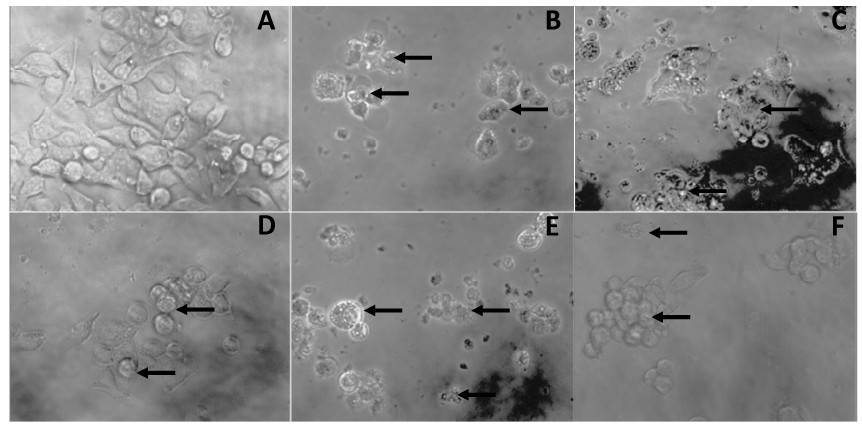
Figure 2. Pro-apoptotic events after 48 h in LS180 cells. Control cells ( A ); treated with gallic acid ( B ); quercetin ( C ); free phenolic extract ( D ); alkaline-treated fraction ( E ); or acid-treated fraction ( F ). Photomicrographs were taken at 100× magnification. Arrows indicate signs of cell blebbing or shrinkage.